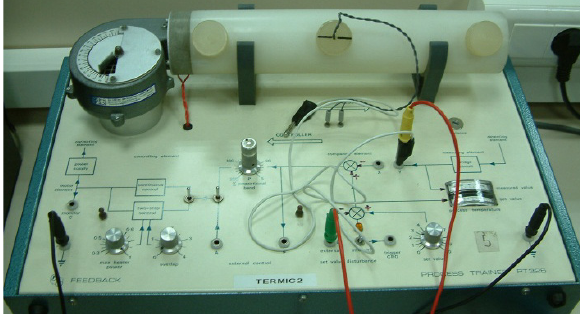
Figure 3. Remote Laboratory Architecture.